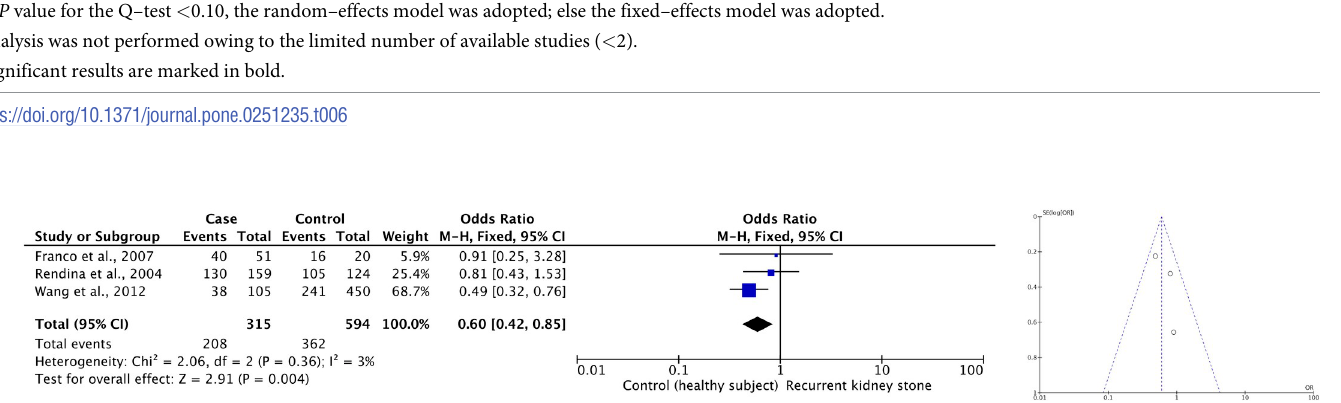
Fig 3. Forest plot and funnel plot of the VDR ApaI polymorphism (dominant model) with healthy subject groups as controls.